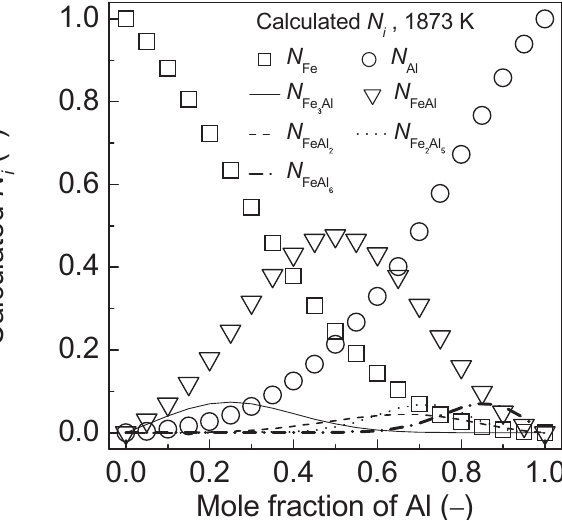
Figure 14: Relationship between mole fraction x Al of Al and calcu- lated mass action concentrations N i of seven structural units as Fe, Al, Fe 3 Al, FeAl, FeAl 2 , Fe 2 Al 5 , and FeAl 6 in full composition range of Fe – Al binary melts at 1873 K (1600°C),